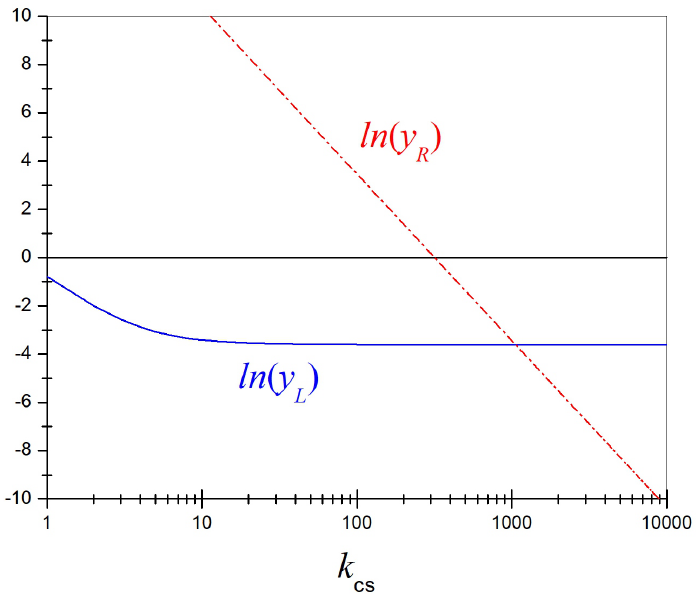
Figure 1. This figure depicts numerical analysis for Equation (26). Here we imply y R = (cid:101) − 1 ( k cs ) − 3 ˜ C and y L = σ E / σ T . The dash-dotted red line represents ln ( y R ) and the solid blue line represents ln ( y L )